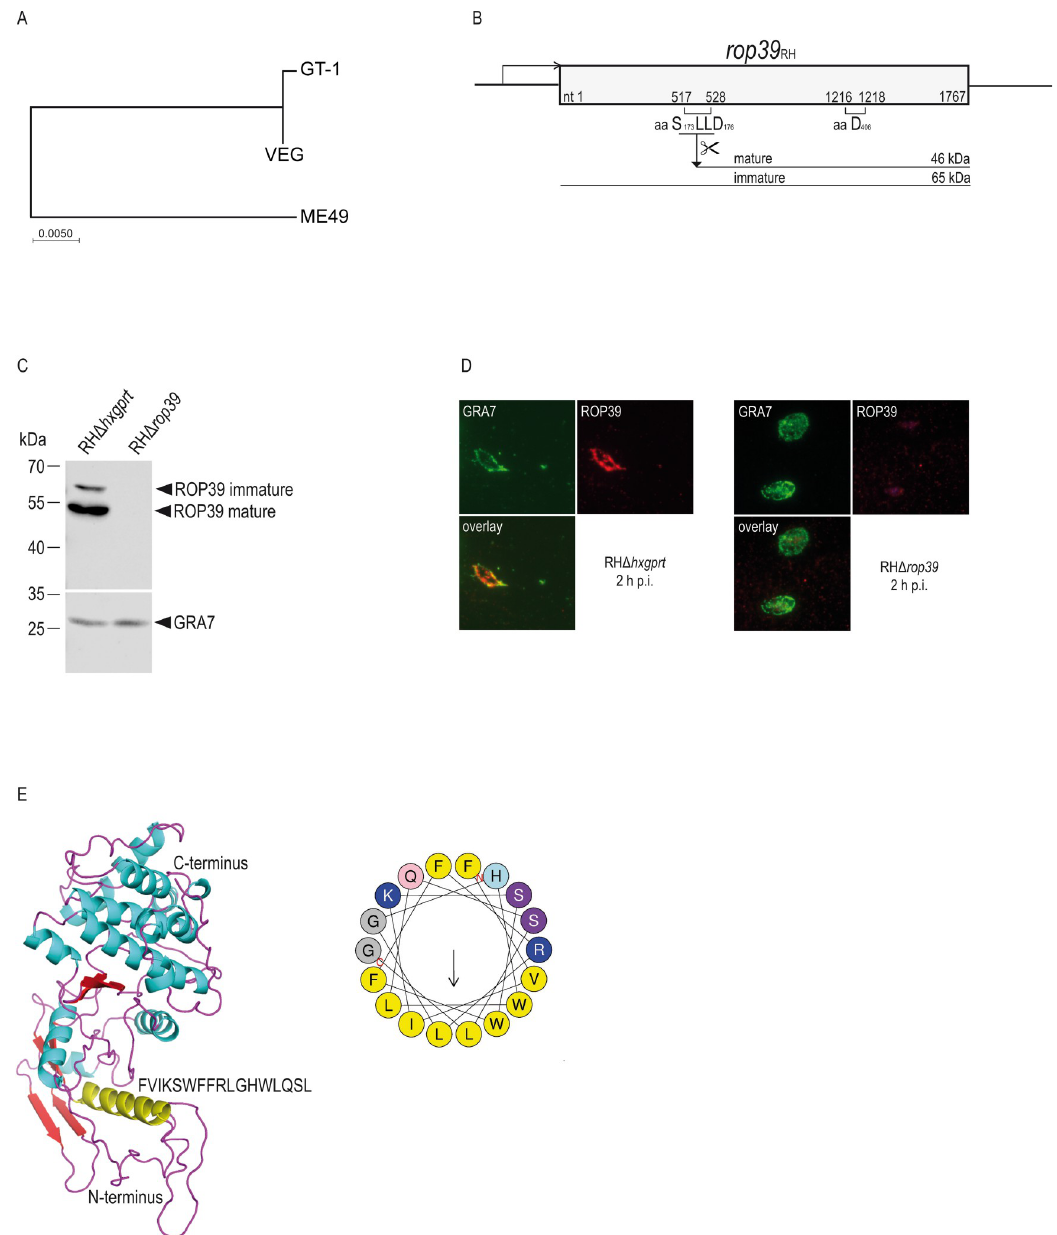
Fig 2. ROP39 is proteolytically processed and localises to the PVM. A, Phylogenetic analysis and maximum likelihood tree of T . gondii ROP39 amino acid sequences from indicated T . gondii strains. B, Schematic representation of rop39 RH at its endogenous locus. The sequence used for proteolytical cleavage (SLLD) of the immature protein and one key catalytic aspartate (D) is depicted. C, Generation of mature ROP39 after proteolytic cleavage and deletion of rop39 in RH Δ hxgprt parasites is demonstrated by Western blot using a ROP39-specific peptide antiserum. D, ROP39 localizes to the PVM in infected host cells. Mouse embryonic fibroblasts were infected with T . gondii RH Δ hxgprt or RH Δ rop39 for 2 h and subsequently stained with a ROP39-specififc peptide antiserum. Intracellular T . gondii were identified by GRA7 staining. E, 3D schematic representation of the ROP39 structure. The N-terminal amphipathic α -helix is shown in yellow. Amphipathic character is indicated by helical wheel projection. (See S1 Fig for data related to A, S2, S11 and S14 Figs for data related to C and S3 Fig for data related to E).